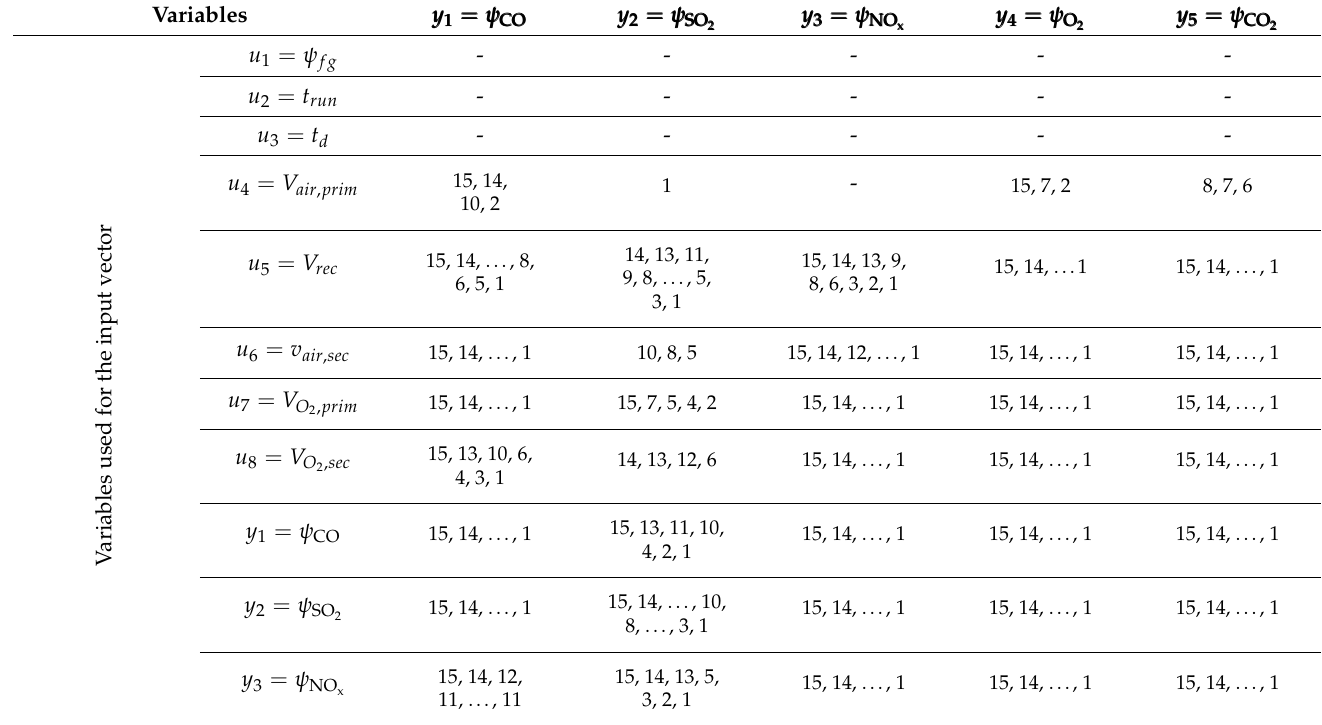
Table 5. Table of state vectors x i for outputs y i (listed in columns) proposed by Boruta Feature Selection Algorithm